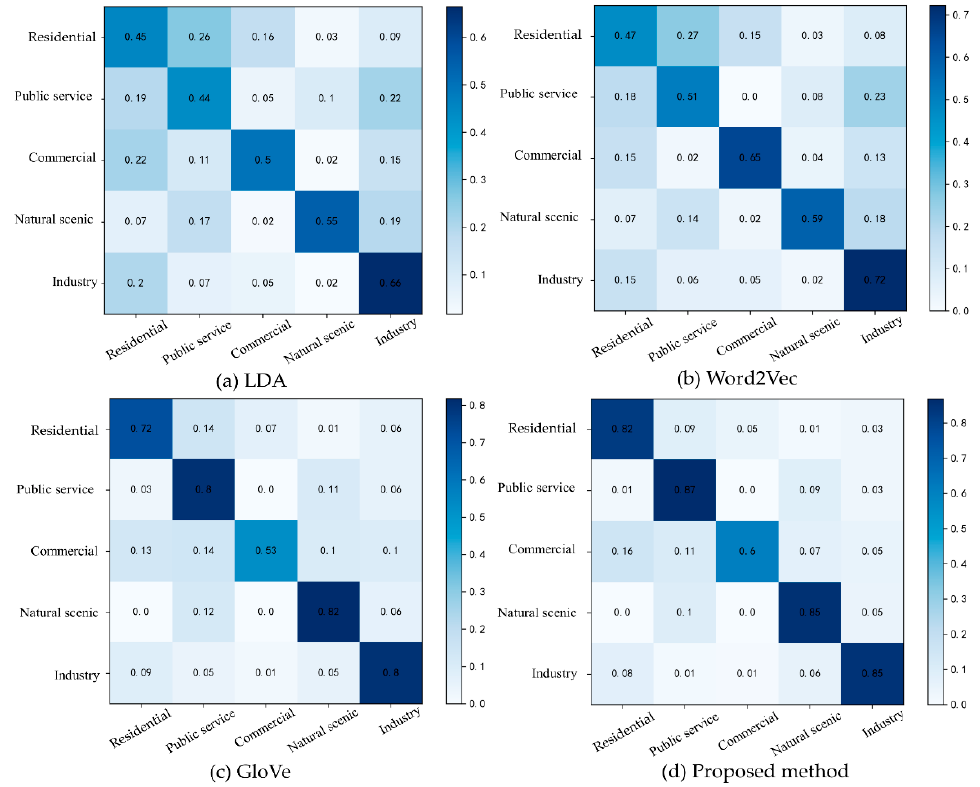
Figure 13. Confusion matrix of identification result based on different methods: ( a ) LDA; ( b ) Word2Vec; ( c ) GloVe; ( d ) proposed method. Table 6. Kappa coefficient and overall accuracy.